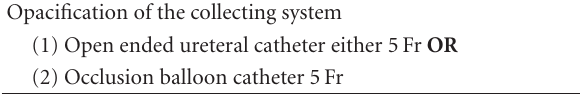
Table 1: Standard products for percutaneous